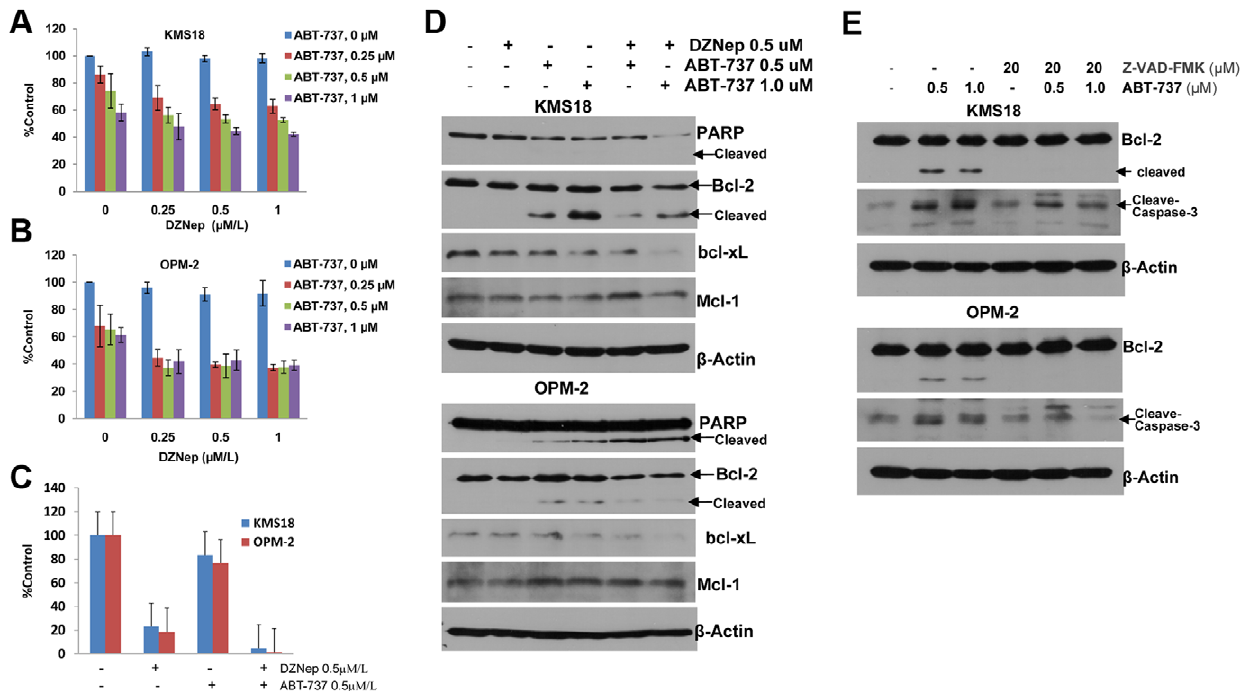
Figure 6. Cotreatment with DZNep and ABT-737 synergistically inhibits growth and induces apoptosis of DZNep insensitive MM cells. (A) Analysis of dose-effect relationship for DZNep (500 nmol/L) and ABT-737 (500 or 1000 nmol/L) for the proliferation after 72 h of exposure in MM cells. The proliferation was determined by MTS colorimetric assay. Data represent the mean 6 SD derived from 3 separate experiments with triplicate wells per condition. After this, the CI values were calculated. CI , 1, CI =1, and CI . 1 represent synergy, additivity, and antagonism of the 2 agents, respectively. (B) Colony formation assay. Data represent the mean 6 SD derived from 3 separate experiments with duplicate wells per condition. (C) After 72 h treatments, total cell lysates were prepared and Western-blot analysis was performed. (D) After treatment with ABT-737 for 48 h, Bcl-2 levels were determined by Western-blot. The Bcl-2 cleavage was inhibited by 1 h of preincubation with a pan-caspase inhibitor Z-VAD- FMK (Promega).